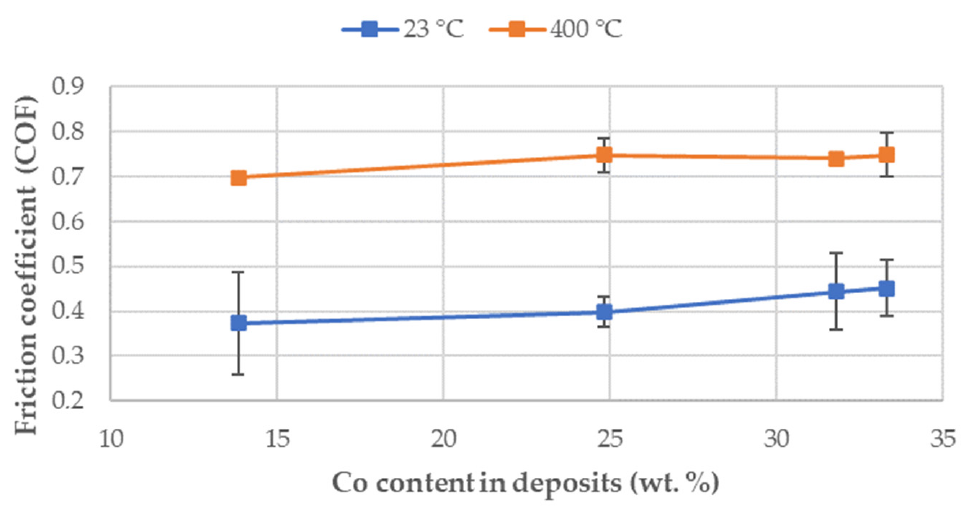
Figure 10. The influence of Co content in coatings on the friction coefficient (COF) at the temperatures of 23 ◦ C and 400 ◦ C.